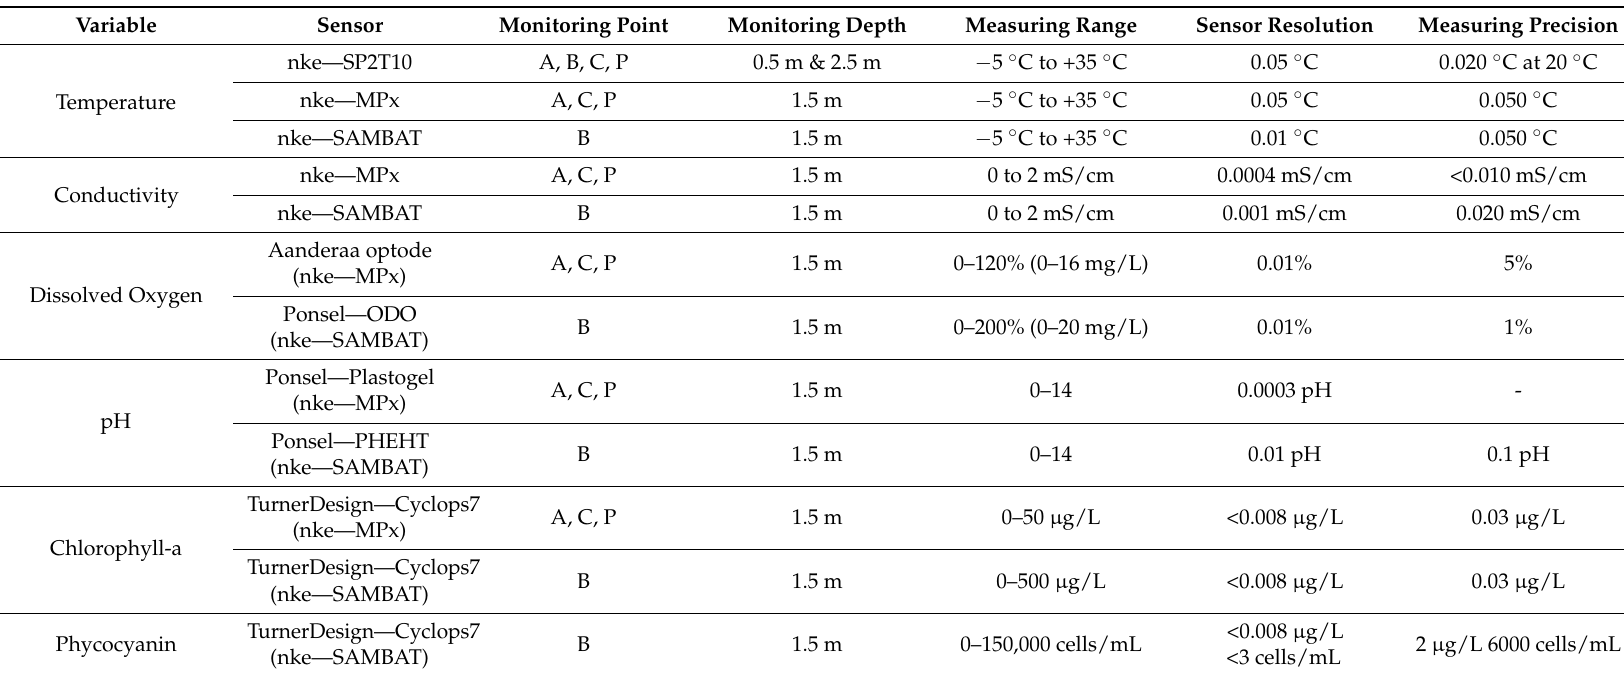
Table 1. Characteristics of high frequency measuring